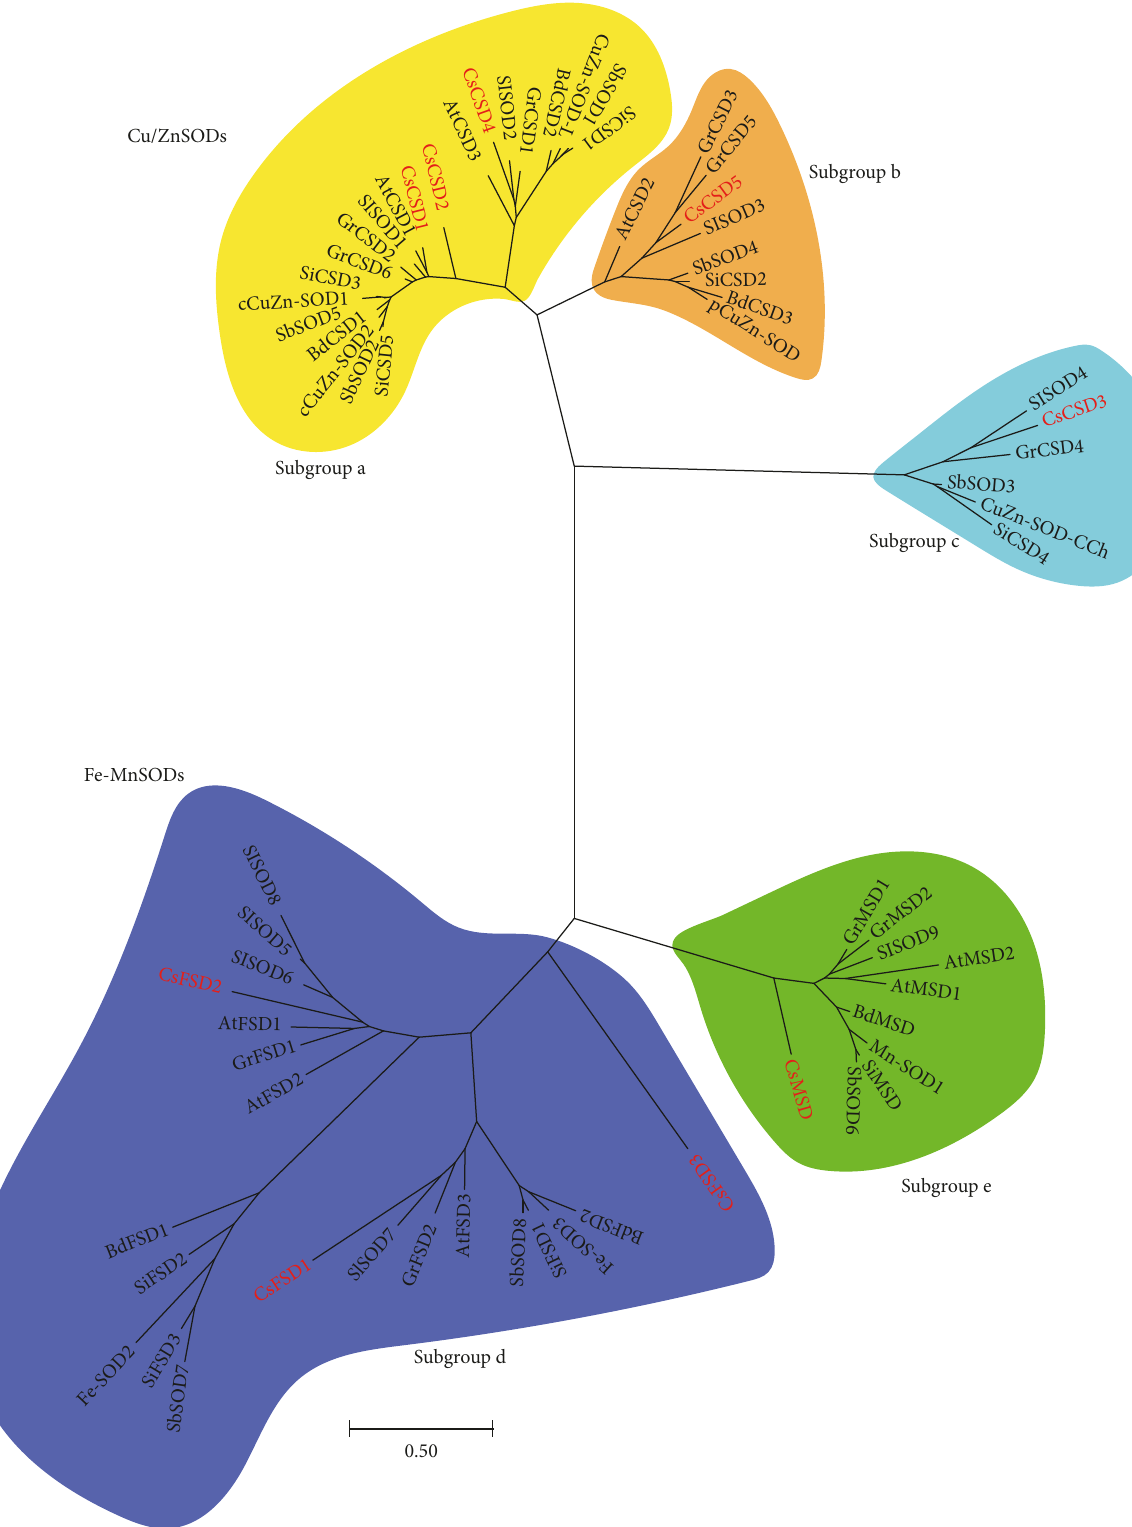
Figure 5: Phylogenetic tree of SOD proteins from cucumber and other plants. Deduced protein sequences of SOD proteins from di ff erent plant species were analyzed by ClustalW and then redrawn with the Geneious Pro software. Five colors (yellow, orange, cyan, blue, and green) represent fi ve subgroups (a, b, c, d, and e), respectively. CsSOD proteins were highlighted in red. The amino acid sequences used to build the phylogenic tree were listed in Table S 4